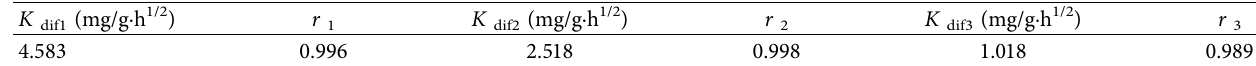
Table 5: Parameters of intraparticular difusion